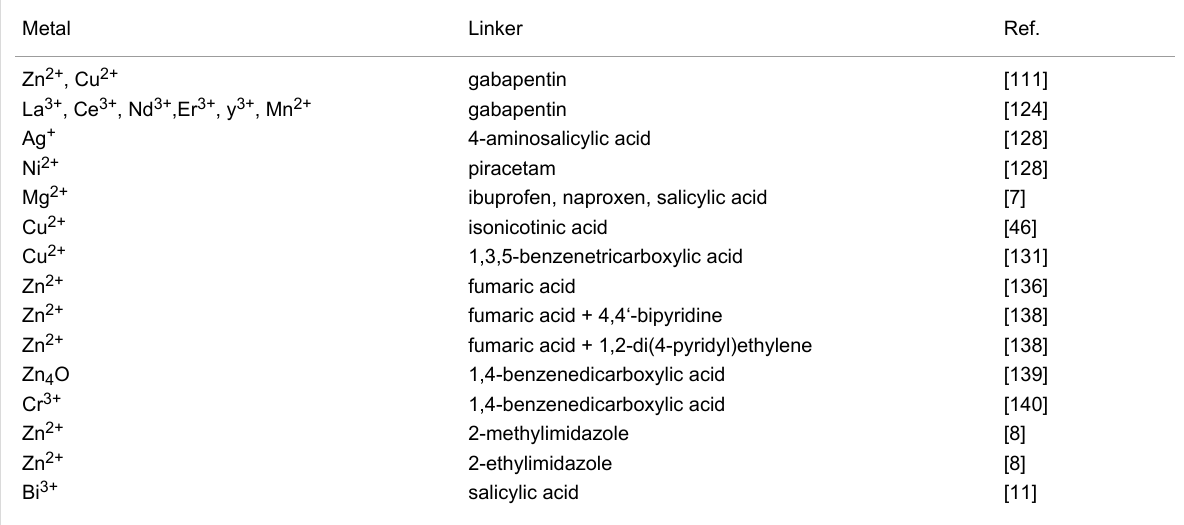
Table 1: Summary of the BioMOFs synthesized by mechanochemistry presented herein. Metal